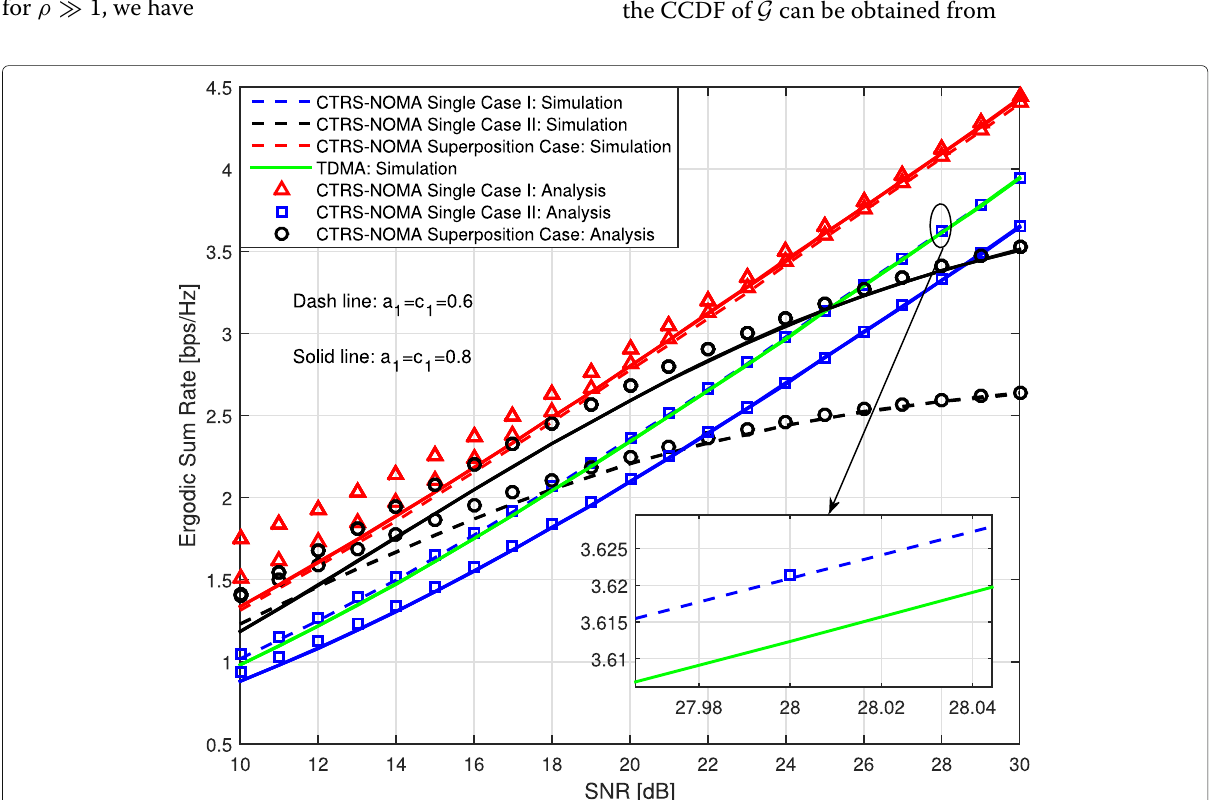
Fig. 3 The ergodic SRs achieved by our proposed CTRS-NOMA single case I, CTRS-NOMA single case II, CTRS-NOMA superposition case, and the TDMA scheme with fixed